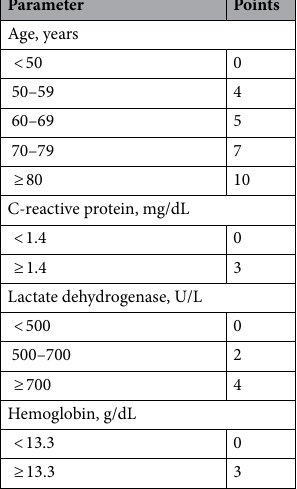
Table 2. The calculator of KDDH